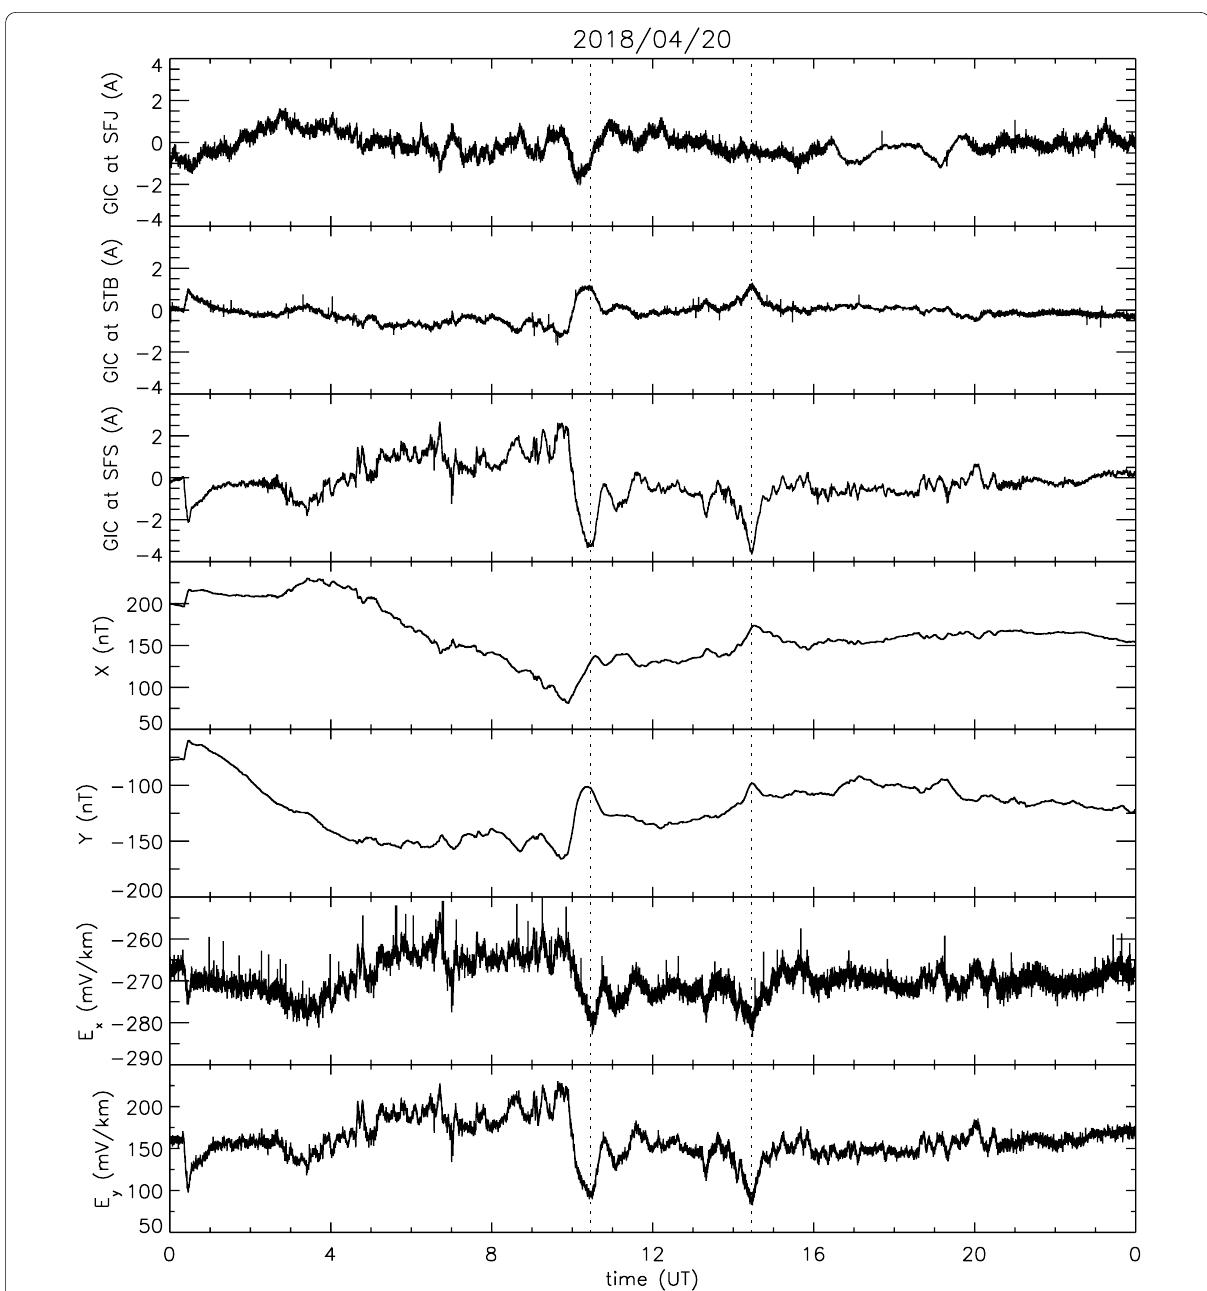
Fig. 4 0.1-s data of GICs at SFJ, STB, and SFS and X- and Y-components of geomagnetic and geoelectric fields at KAK of the 20 April 2018 geomagnetic storm. Vertical dotted lines show the excursions of GICs noted in the